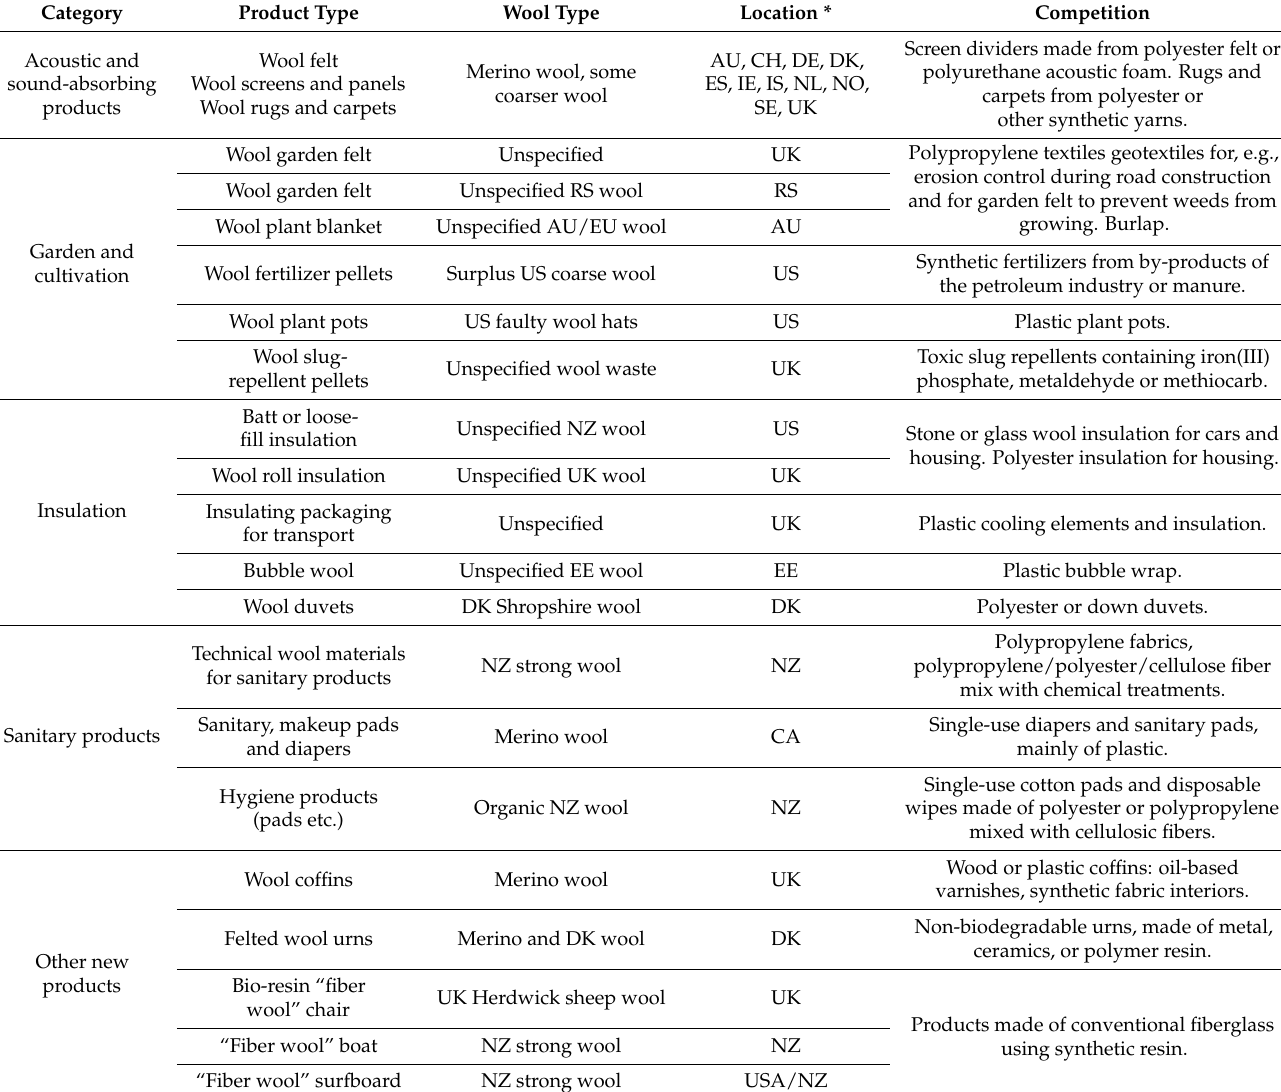
Table 2. Wool products by category, product type, wool type used, location and